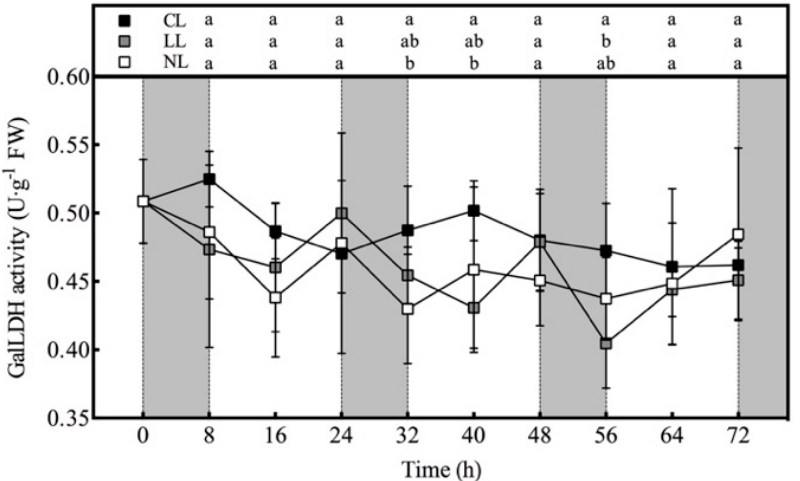
Figure 2. Effects of light intensities at night time on the activity of GalLDH in lettuce leaves under red and blue continuous light.